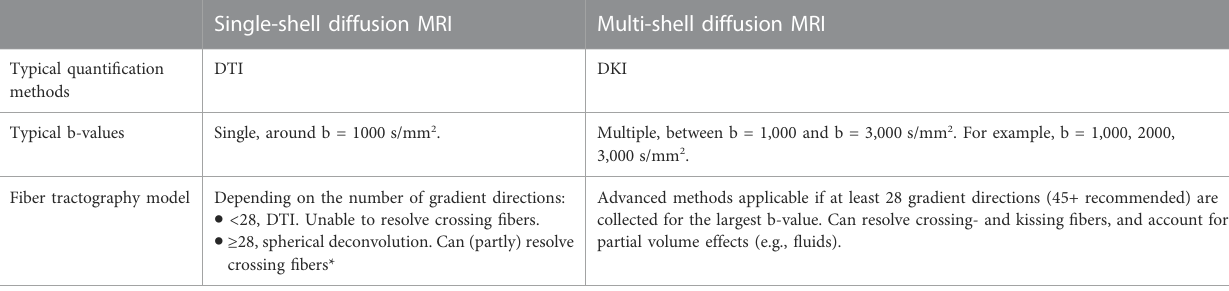
TABLE 2 Difference between single- and multi-shell diffusion MRI acquisition for brain tumor imaging. Single-shell diffusion